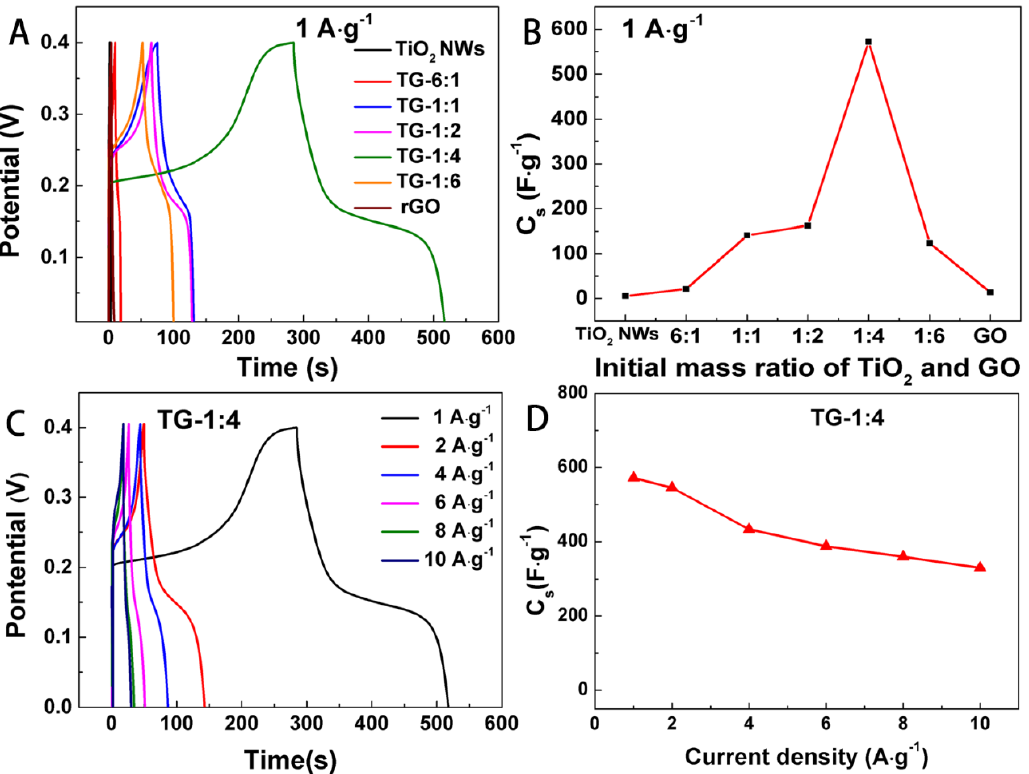
Figure 7: Electrochemical performance. A: GCD curves of the TiO 2 NWs-rGO nanocomposites at 1 A · g −1 . B: Specific capacitance of the TiO 2 NWs-rGO nanocomposites at 1 A · g −1 . C: GCD curves of the TG-1:4 at various current densities. D: specific capacitances of the TG-1:4 at various current densities